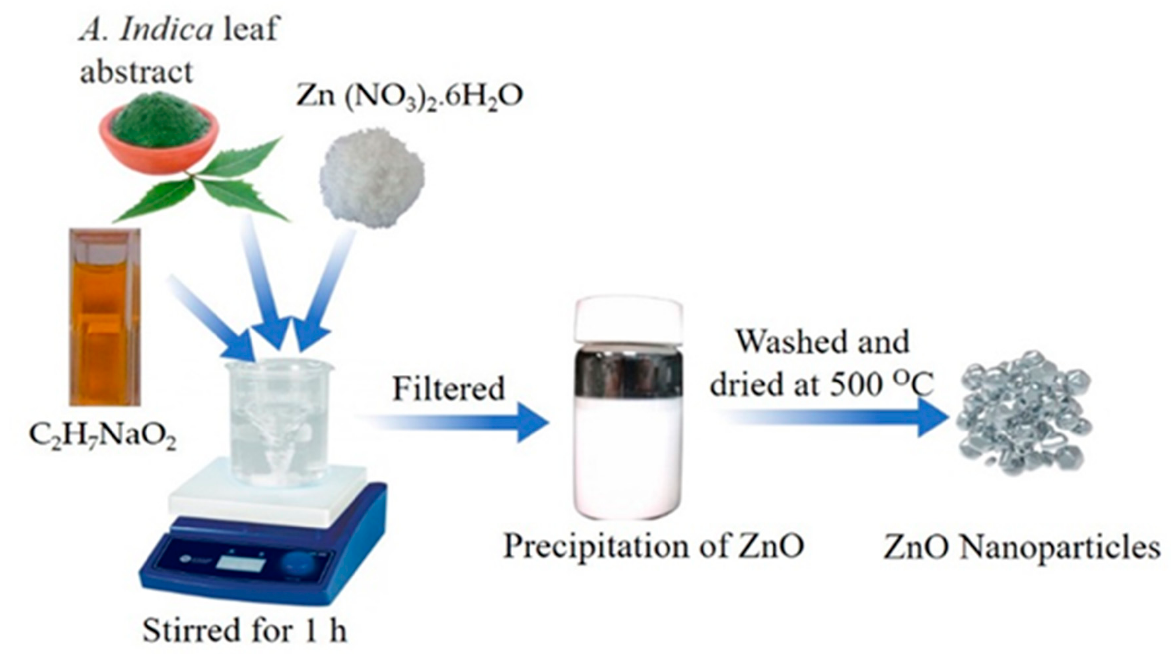
Figure 9. Schematics of the synthesis of ZnO using the green scheme.